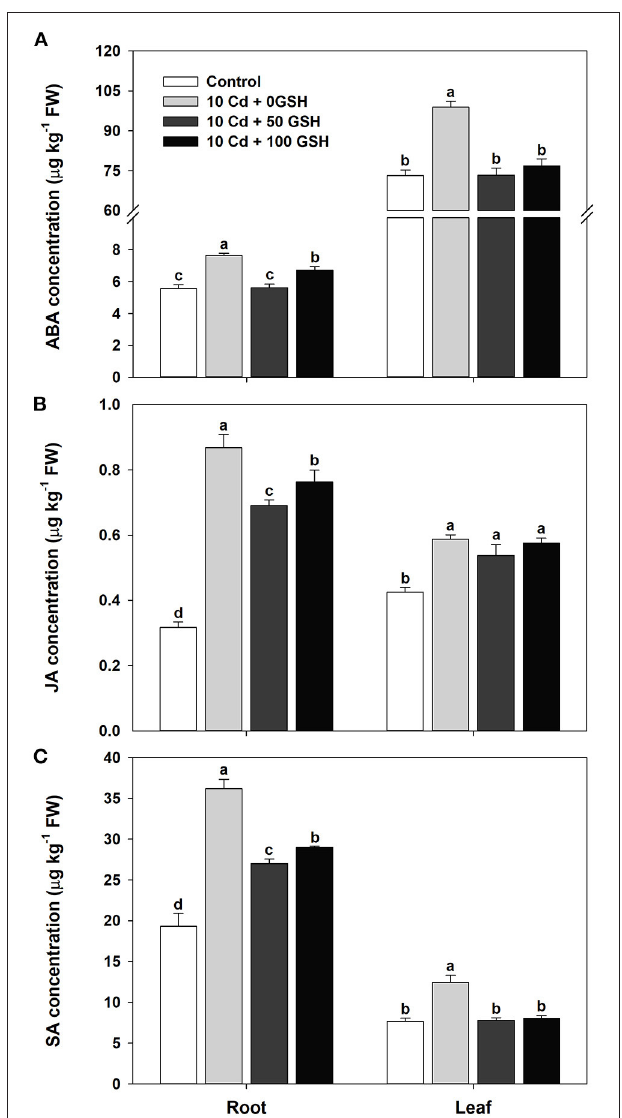
FIGURE 5 | Stress-associated hormone concentrations in the roots and leaves of oilseed rape plants grown under control (no Cd or GSH) or 10 µ M Cd stress conditions sprayed with/without GSH (0, 50, and 100mg kg − 1 ). (A) Abscisic acid (ABA), (B) jasmonic acid (JA), and (C) salicylic acid (SA) (C) concentrations. The concentration of each hormone was measured 10 days after treatment. Data are presented as mean ± SD ( n = 3). Means denoted by the same letter are not significantly different at the P < 0.05 level according to Fisher’s least significant difference (LSD)